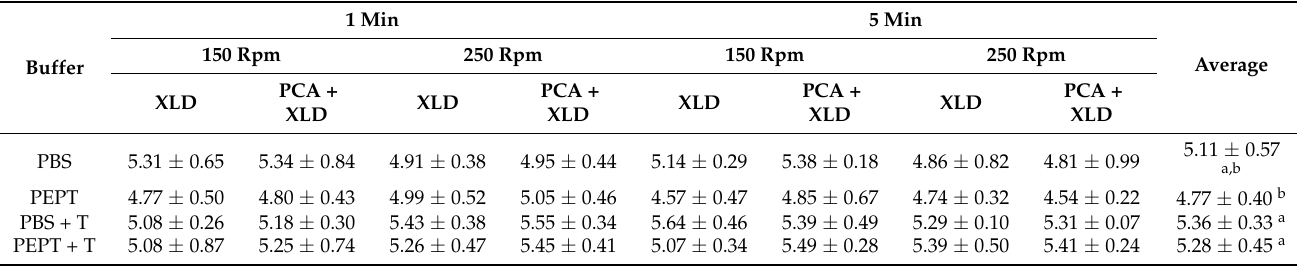
Table 1. S. Typhimurium population (log CFU) recovered from papaya surface as affected by homogenization buffer, time (min), speed (rpm) and enumeration methods